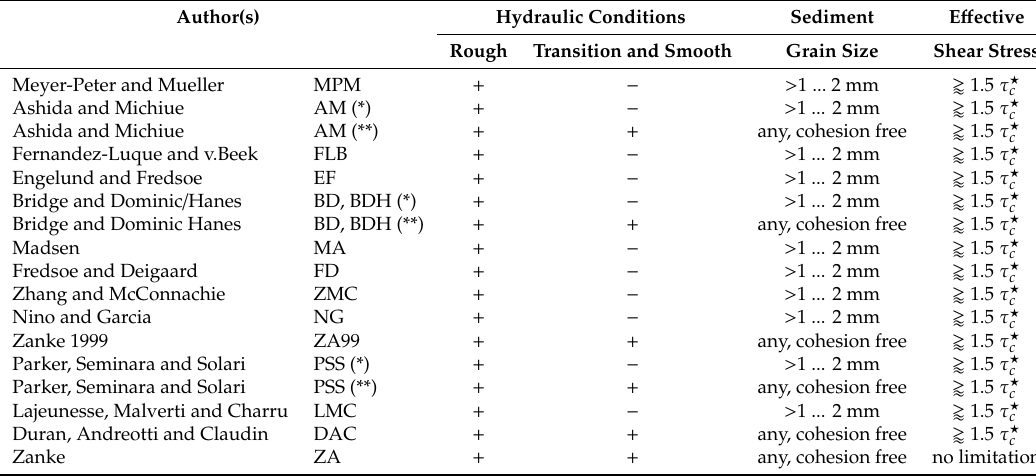
Table 4. Application limits. (*) = coe ffi cients as proposed by the author(s), (**) = as derived by the author(s), but proposed coe ffi cients